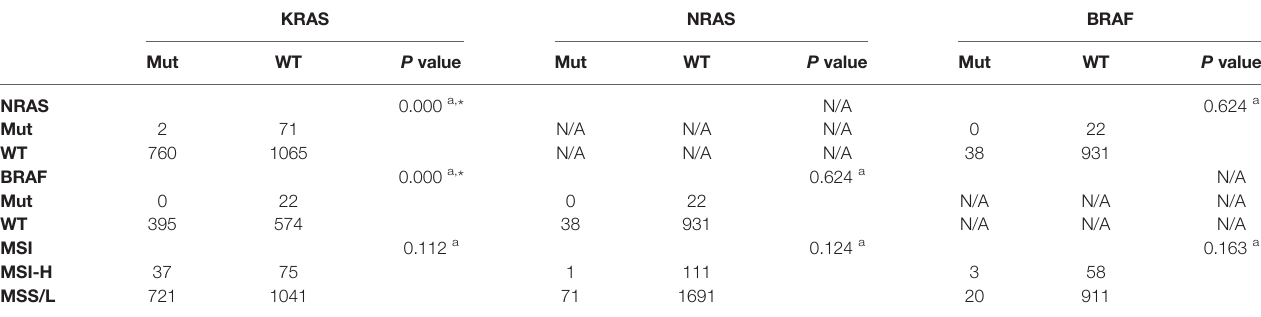
TABLE 4 | The interactions between molecular marker status.